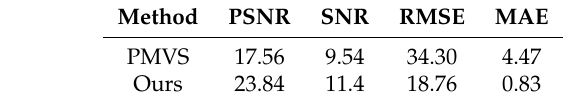
Table A1. Quantitative evaluations of the Patch-based Multiview Stereo (PMVS) method and our method.